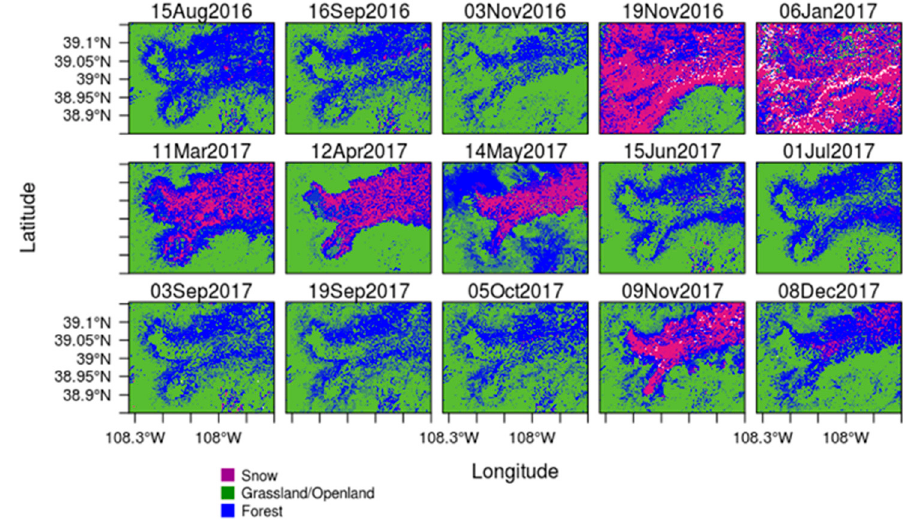
Figure 7. Grand Mesa vegetation classification (2016–2019) from Landsat-8 (cloud-free days) based on the Spectral Variability Vegetation Index (SVVI) at 30 m resolution.